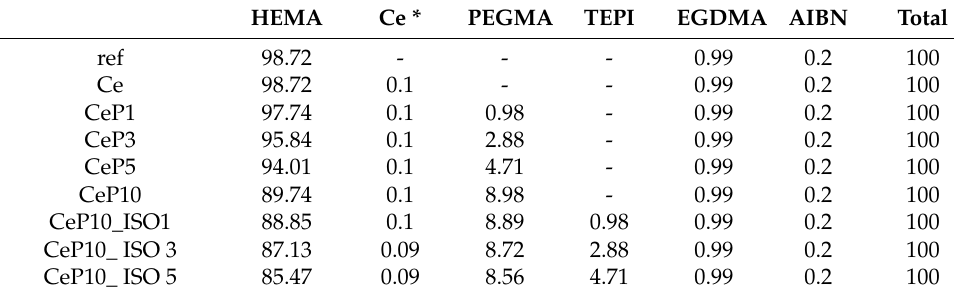
Table 1. Percent composition of samples (unit: